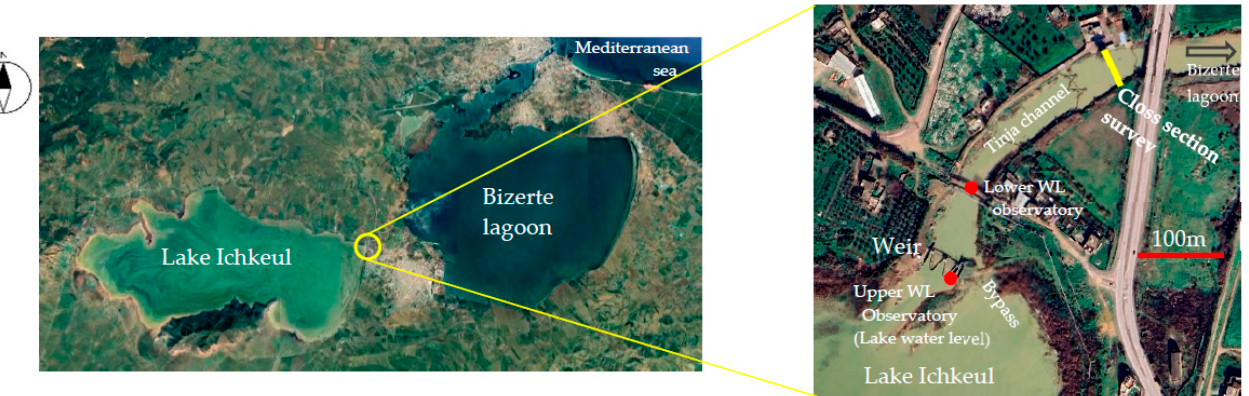
Figure 6. The relationship between the lake water level and the forward flow calculated from the gradient between the lower WL observatory and seawater level.